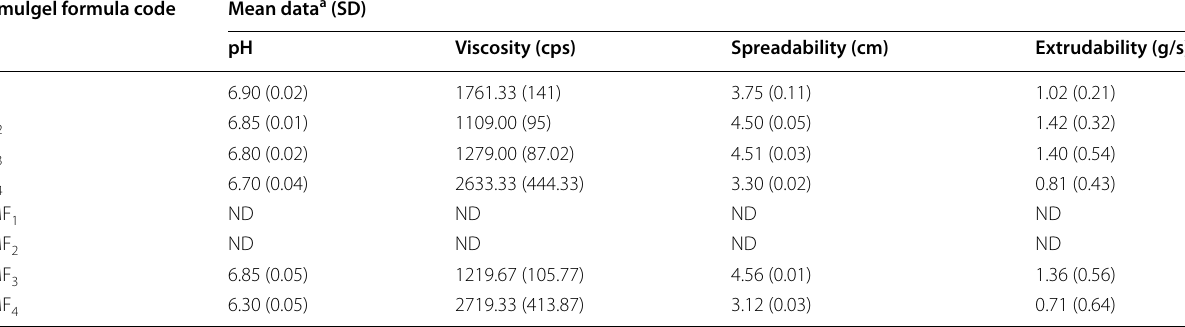
(F1–F 4 ) refer to plain emulgels prepared with Carbopol 940, Na CMC, Na alginate and HPMC E4, respectively. (M‑F1–M‑F 4 ) refer to medicated emulgels containing 4% LRJ and 50% GE and prepared with Carbopol 940, Na CMC, Na alginate and HPMC, respectively ND not determined, SD standard deviation a Average of three